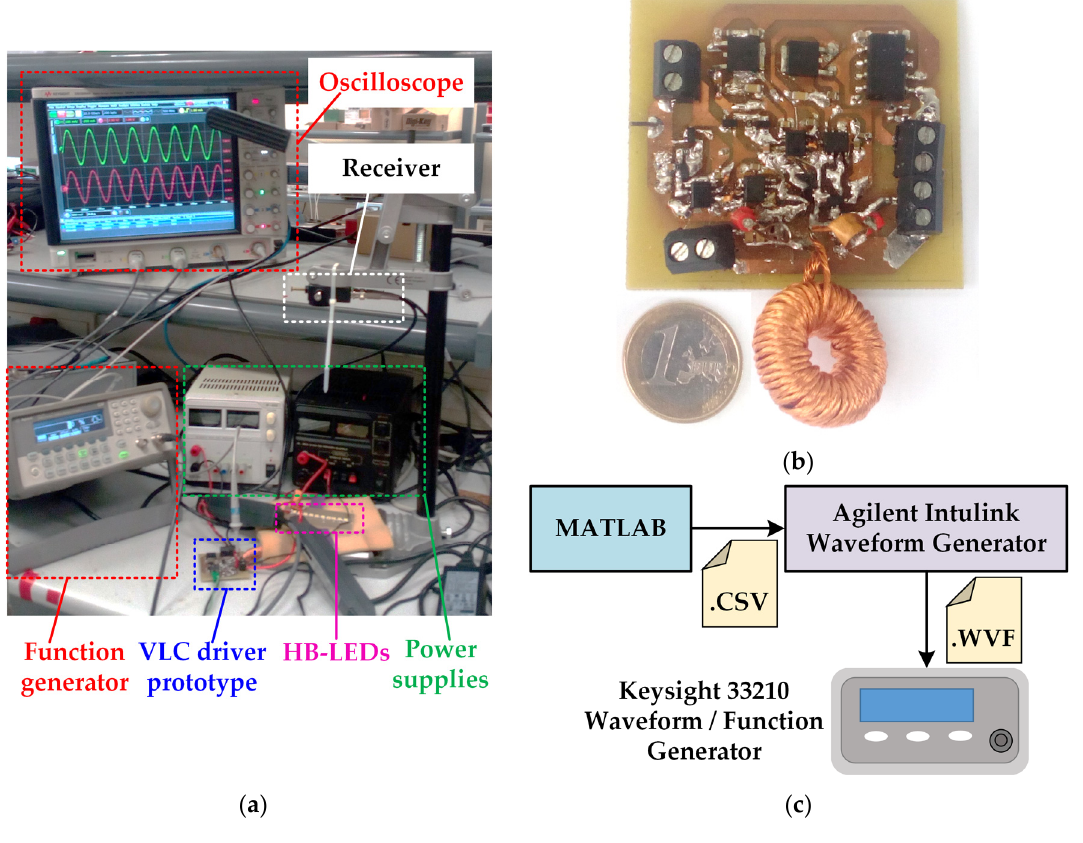
Figure 13. Experimental VLC link: ( a ) Setup. ( b ) RF-PWM Class D SMPA prototype. ( c ) Scheme of the digital platforms used to generate v control (t) .